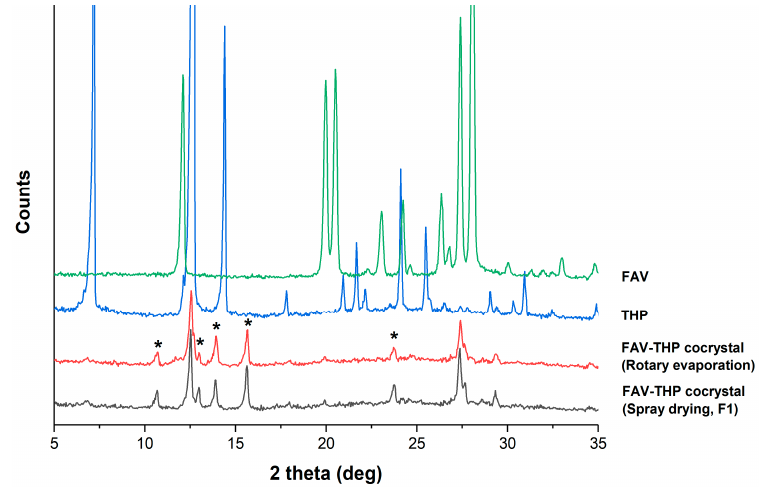
Figure 2. PXRD patterns of the FAV-THP cocrystal system. New characterization peaks of the cocrystal are marked with *.